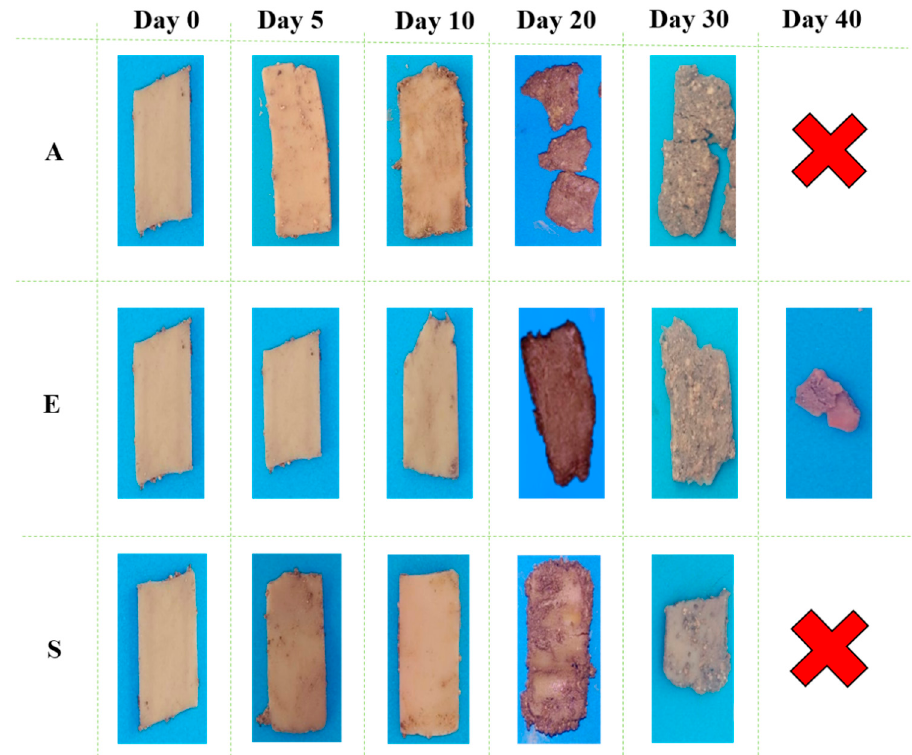
Figure 6. Images of the different matrices at different times in the biodegradation study. Note: The width of samples in day 0 is 10 cm, the other images were obtained at the same focus from the camara.